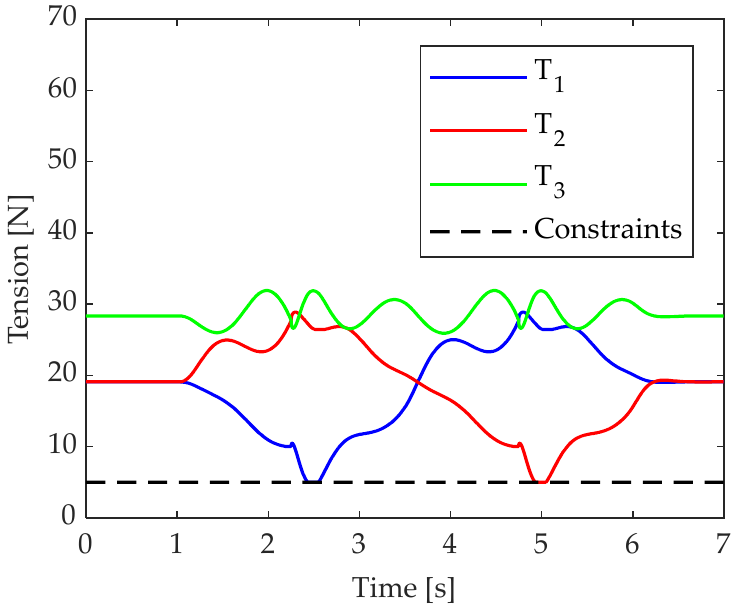
Figure 9. Cable tensions in the execution of the Gerono’s lemniscate.